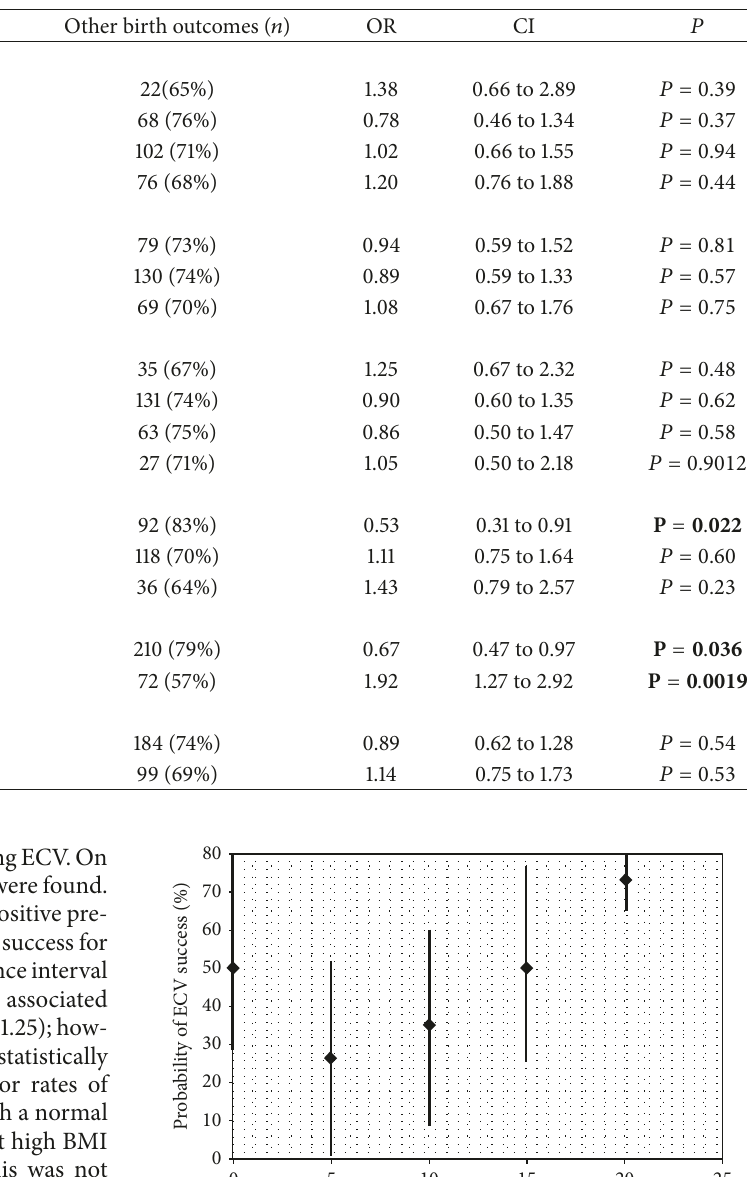
Table 3: Predictors of cephalic vaginal delivery in patients undergoing ECV.